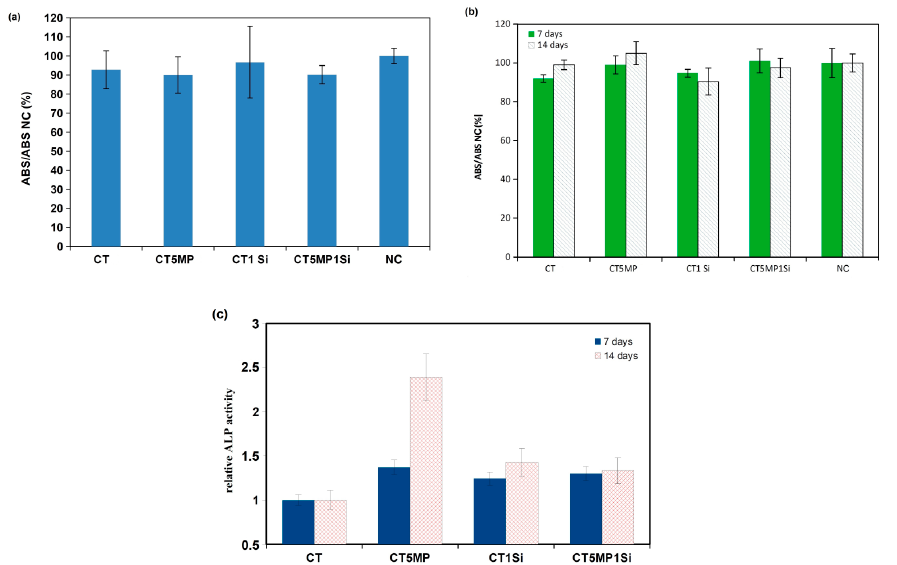
Figure 7. Viability of MC3T3E1 cells ( a ) cultured in 100% cement extracts for 24 h; viability of differentiated rat MSCs cultured ( b ) and ALP activity ( c ) of differentiated rat MSCs cultured in 50% cement extracts for 7 and 14 days.